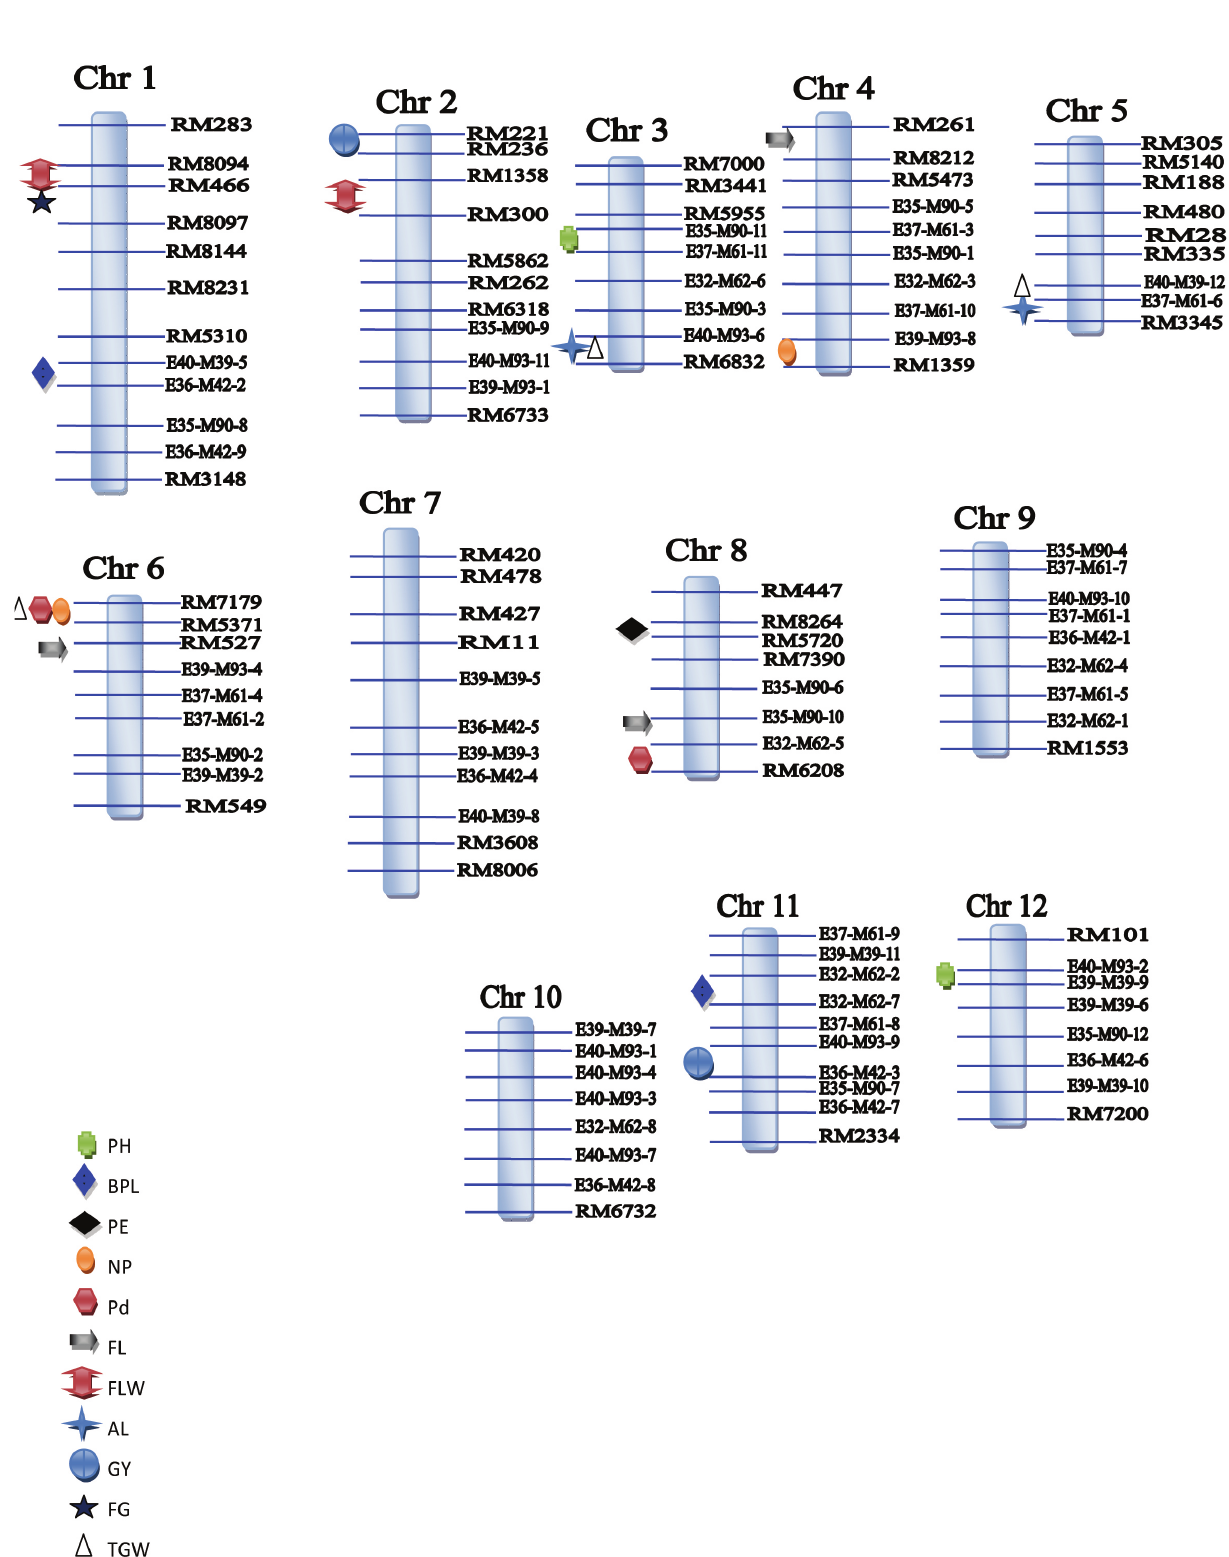
Fig. 2. QTLs that were mapped for: full grain per panicle (FG), flag leaf width (FLW), 1000-grain weight (TGW), number of panicles per plant (NP), flag leaf length (FL), peduncle length (Pd), plant height (PH), panicle exertion (PE), grain yield (GY), basal panicle length (BPL) and awn length